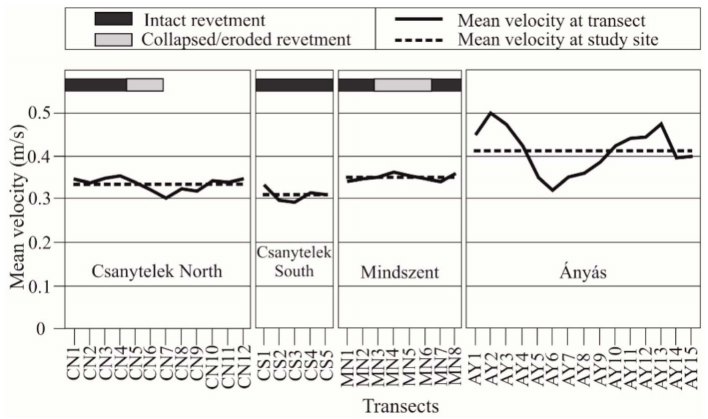
Figure 9. Characteristic velocity values at the study sites and the locations of revetments on the western